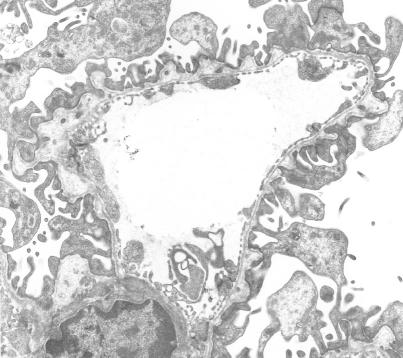
Transmission electron microscopy of a kidney from an α3(IV)
−/− mouse. Without treatment, glomerular basement membrane lesions and podocyte effacement cause severe proteinuria in these mice.